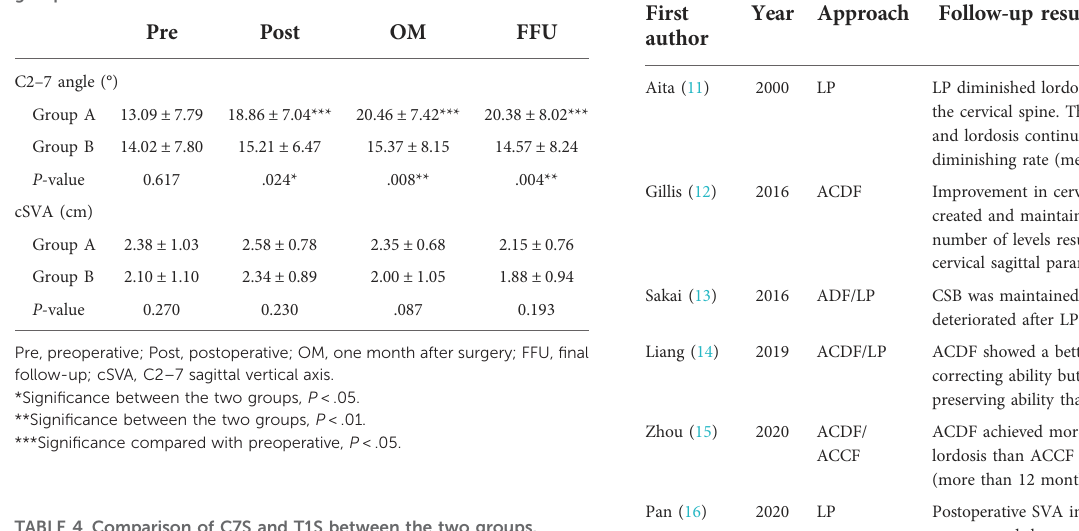
TABLE 5 Mini-review on the anterior/posterior approach and